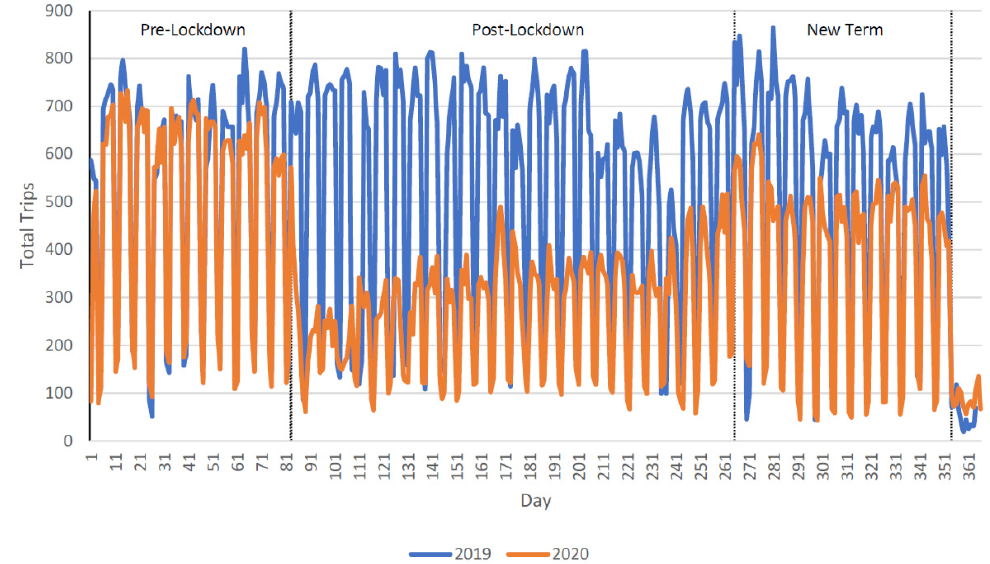
Figure 3. Total number of trips taken by the tracked vehicles on each day of the year. Three periods were identified for 2020: preceding the first UK national lockdown; between the start of the first lockdown and the start of the 2020/2021 academic year; and the first term of the academic year.